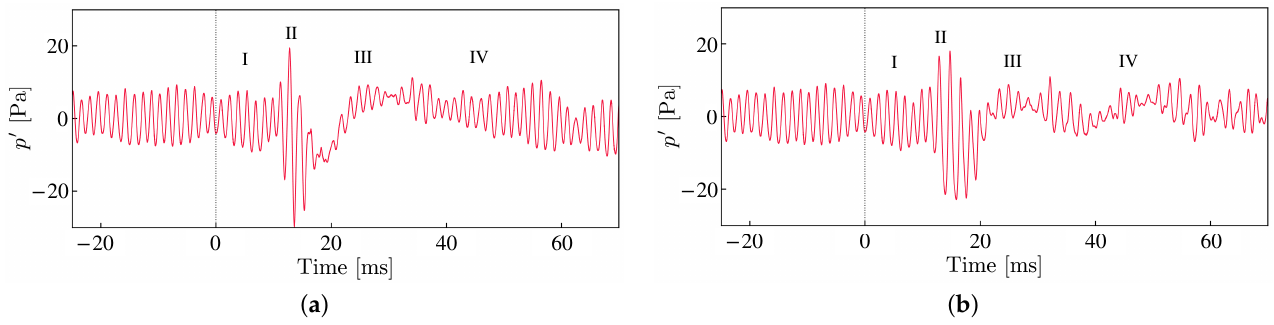
Figure 13. Pressure fluctuations p (cid:48) measured at x = 225 mm (90% chord position) on the pressure side surface. ( a ) Narrow; ( b )